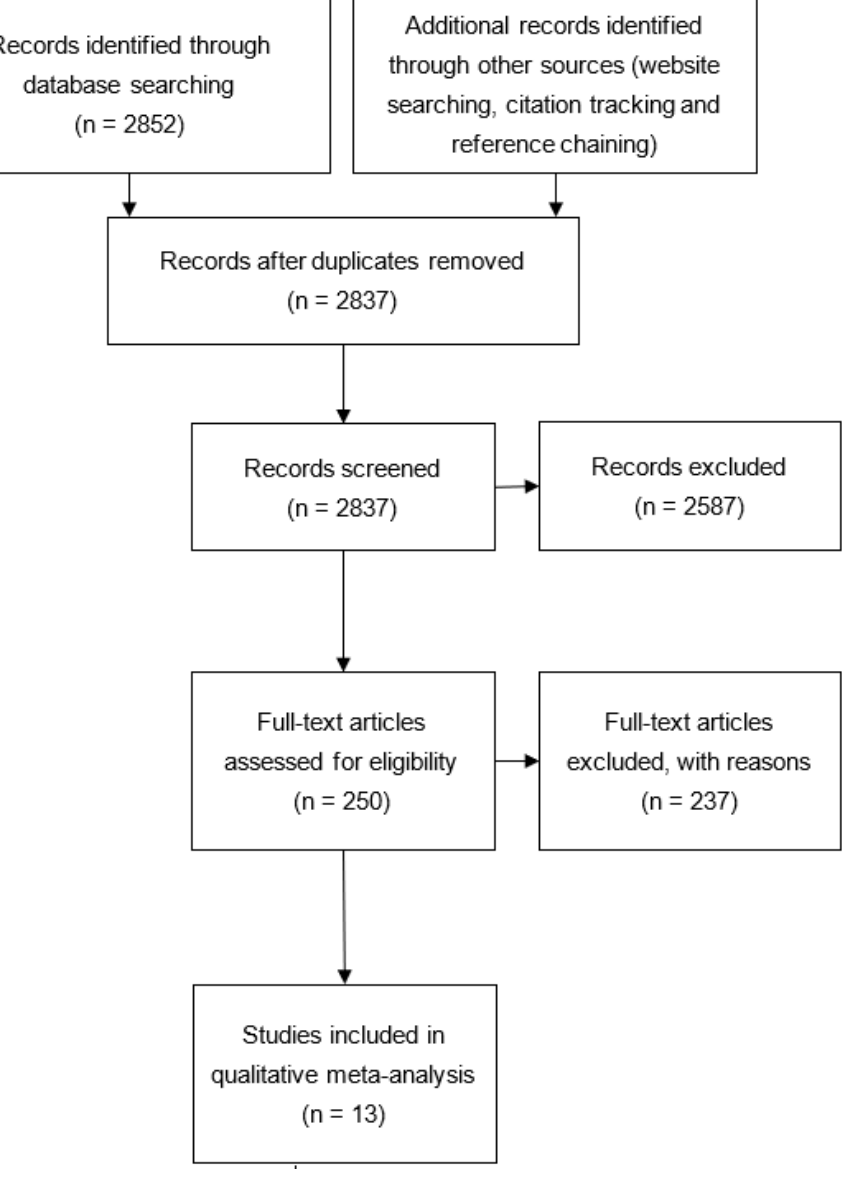
Figure 1. PRISMA flow diagram.